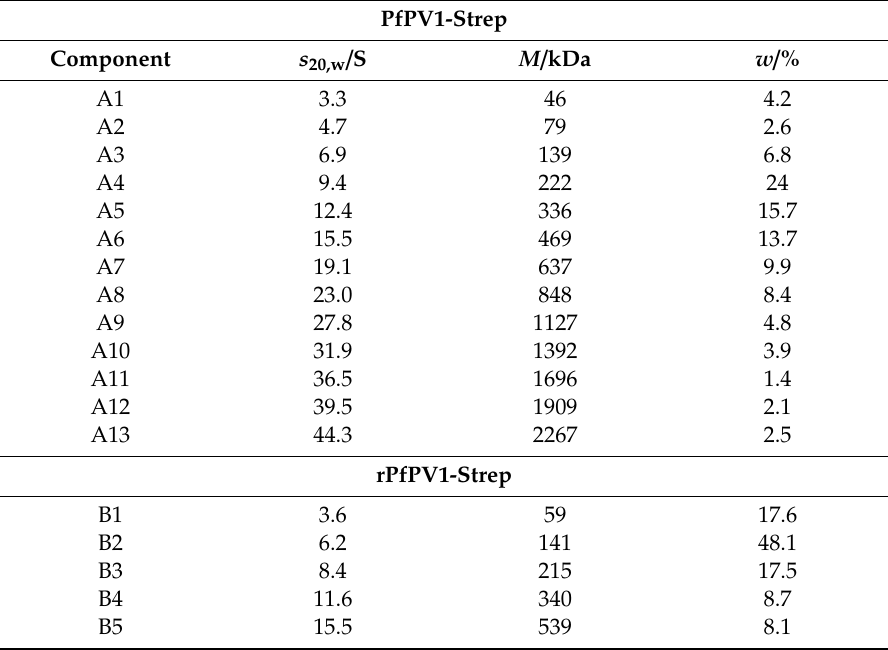
Figure 4. Sedimentation velocity analytical ultracentrifugation (SV-AUC) analyses of PfPV1-Strep ( A ) and rPfPV1-Strep ( B ). ( A ) Solid purple line represents c ( s 20,w ) obtained with SV-AUC. Solid black line shows the result of the least square fitting with the summation of 13 Gaussian curves each of which corresponds to the components A1–A13: The dotted lines also express the fitting lines for the components and the peak potions are marked with the labels of A1–A13. PfPV1- Strep has high polydispersity. A protein series was detected in the range of 46–2267 kDa with 222 kDa as the main constituent factor. ( B ) Solid green line represents c ( s 20,w ) obtained with SV-AUC. Solid black line shows the result of the least square fitting with the summation of 5 Gaussian curves each of which corresponds to the components B1–B5: The dotted lines also express the fitting lines for the components and the peak potions are marked with the labels of B1–B5. The main proportion, sharing 48.1 w / %, was 141 kDa corresponding to trimers. Almost the same amount of oligomers (59 kDa corresponding to monomers, 214 kDa corresponding to tetramer) were detected additionally. Table 1. Parameters of the components of SV-AUC.